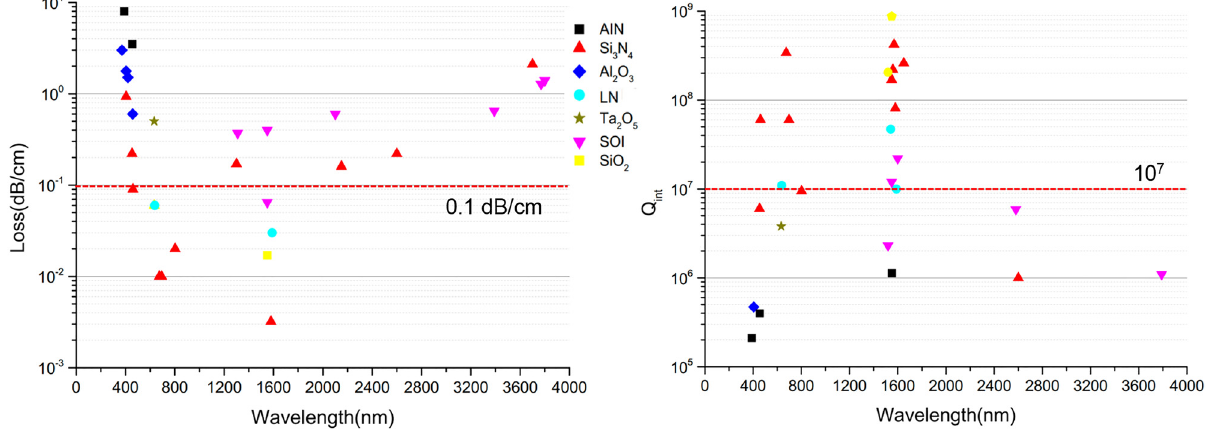
Figure 5: Summary of reprehensive waveguide losses and intrinsic Q factors of different optical materials on silicon platform across visible, near IR, and mid-IR spectra. (left) Waveguide loss of SiO [91], and LN [109, 110]. (right) Intrinsic Q values in different optical materials of SiO